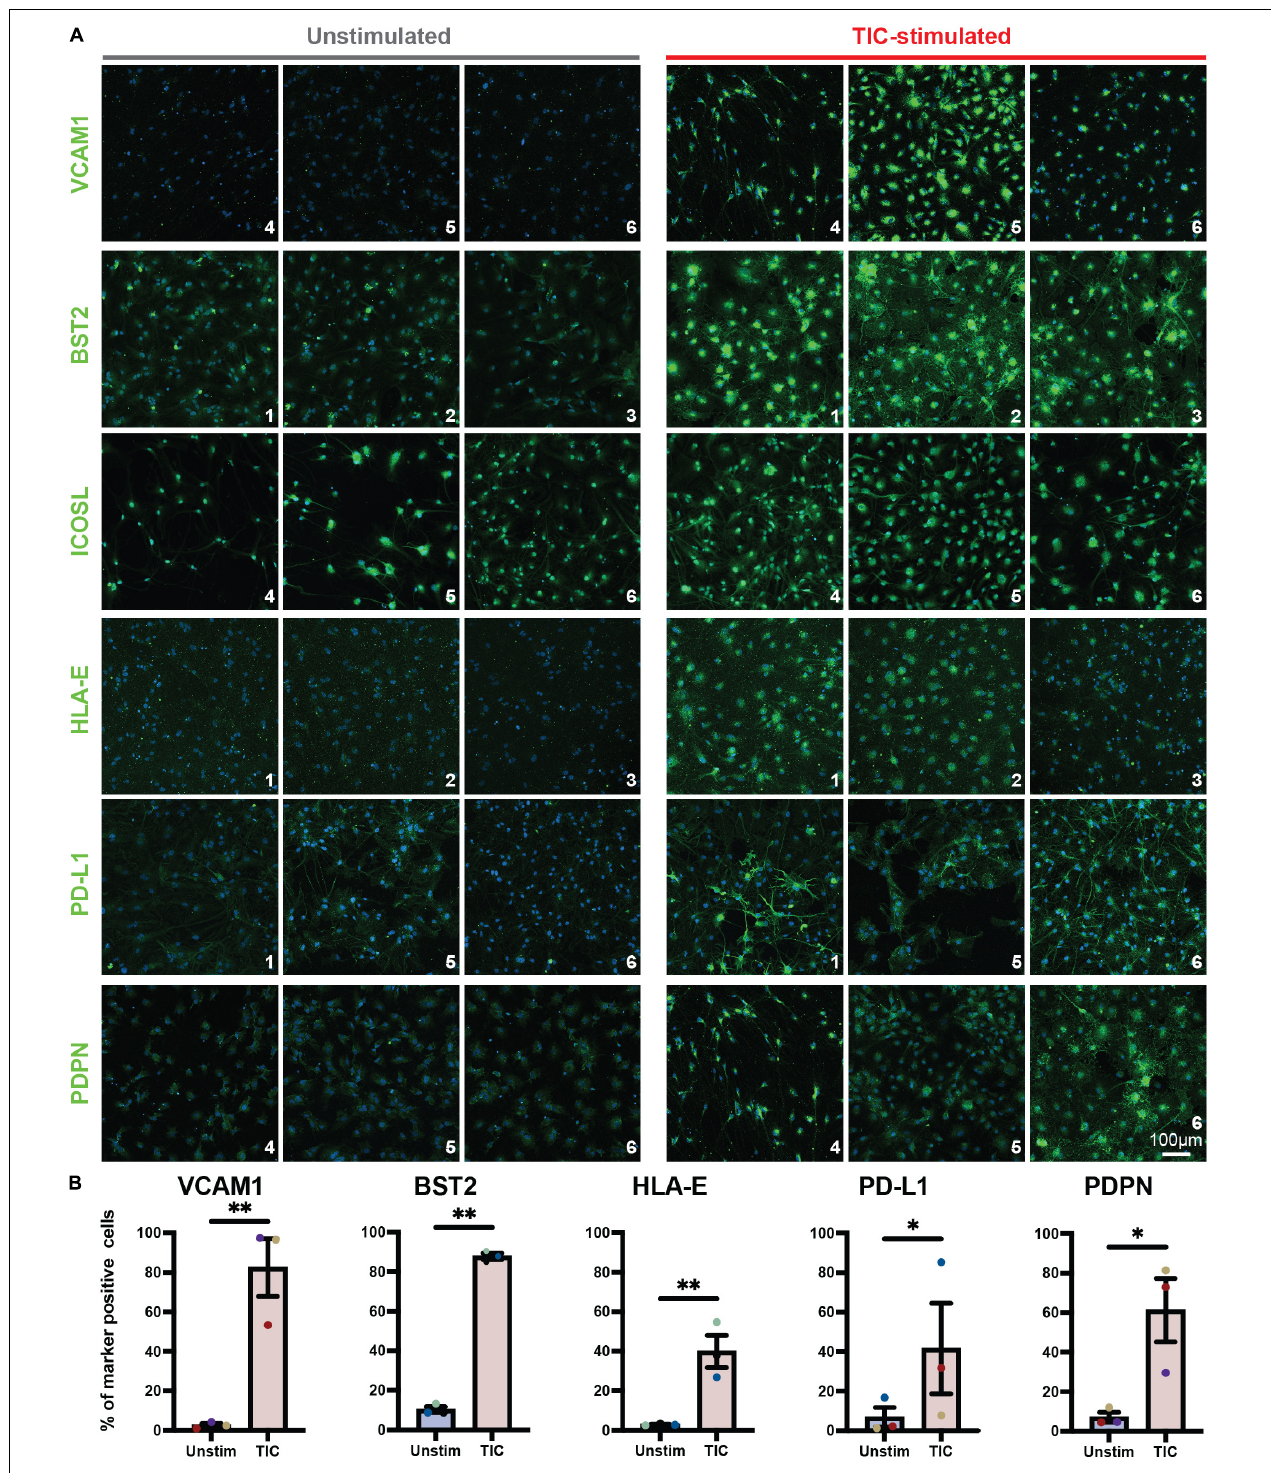
FIGURE 2 | Immunofluorescence analysis of novel TIC-reactive markers in CD49f + -sorted astrocytes. (A) Independent immunofluorescence analysis on CD49f-purified astrocytes using antibodies conjugated with fluorescent secondaries. All markers (with the exception of ICOSL) are enriched in TIC-stimulated astrocytes, validating the flow cytometry findings. Each marker is shown in AF488 (green) and nuclei are labeled with Hoechst 33342 (blue). Each marker was tested on astrocytes derived from three hiPSC lines ( n = 3); line code numbers are shown in the bottom right corner of each image. (B) Quantification of marker-positive cells shown as percentage of total cells (all nuclei). Error bars represent standard error of means. p -value was calculated using ratio paired t -test. *, p -value < 0.05; **, p -value < 0.01.